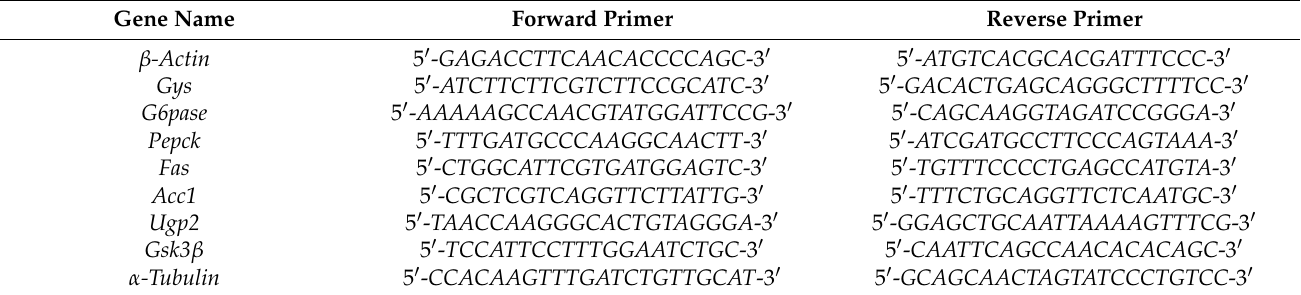
Table 1. Gene sequences of